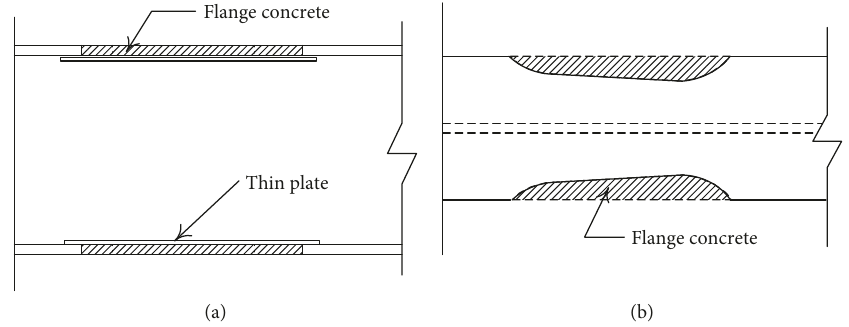
Figure 19: Flange concrete of PW specimens. (a) Side view. (b) Top